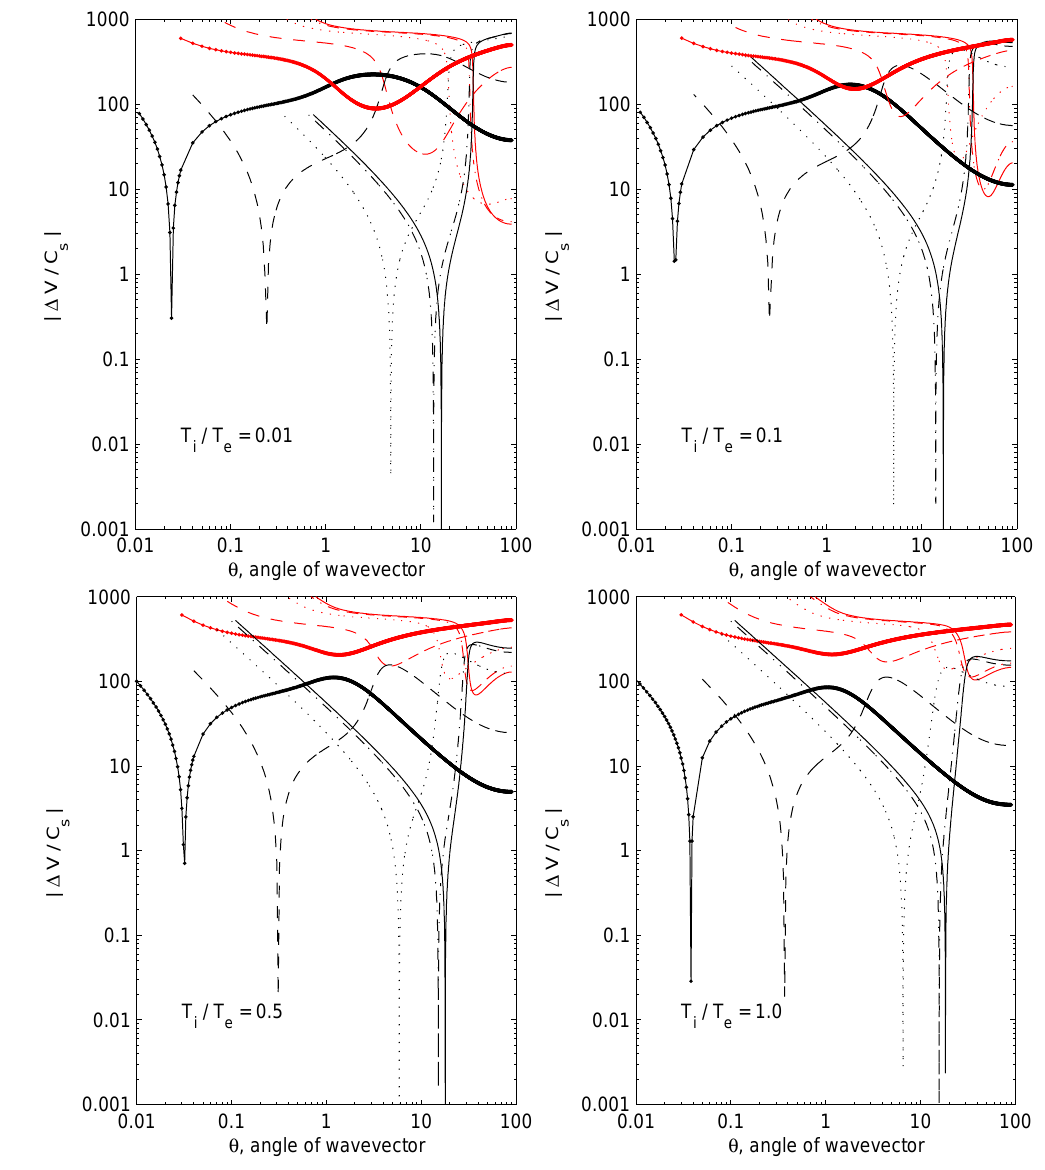
Fig. 4. Relative drift as a function of wavevector angle for the case described in Fig. 3. The angle is 0 ◦ when the angle is perpendicular to B and 90 ◦ when parallel to it. The line scheme is the same as in Fig.